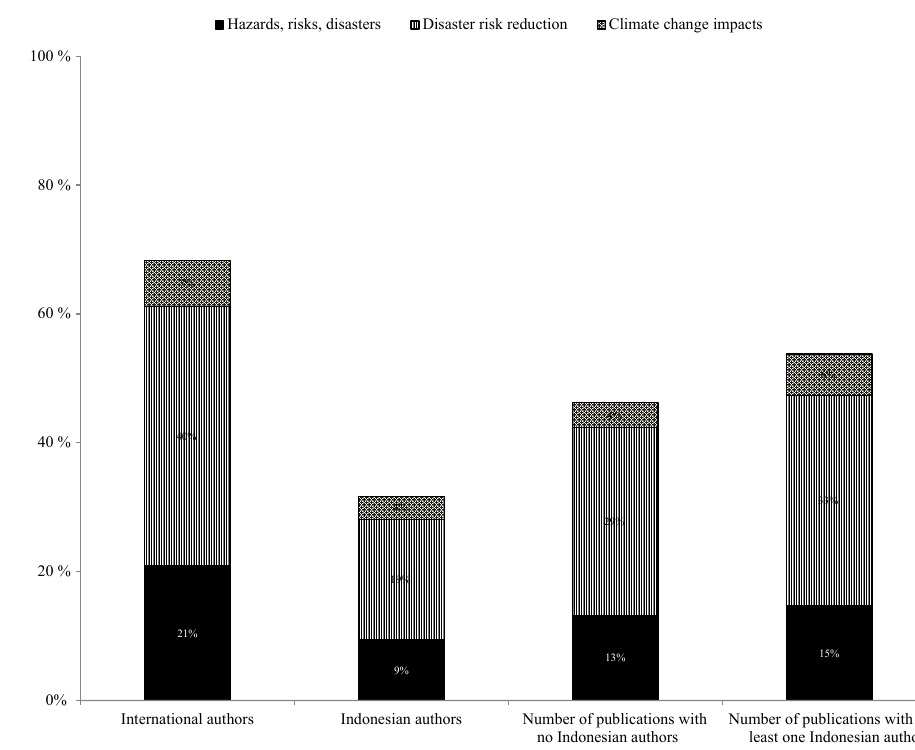
Figure 5. Comparing the roles of international and Indonesian authors in each publication